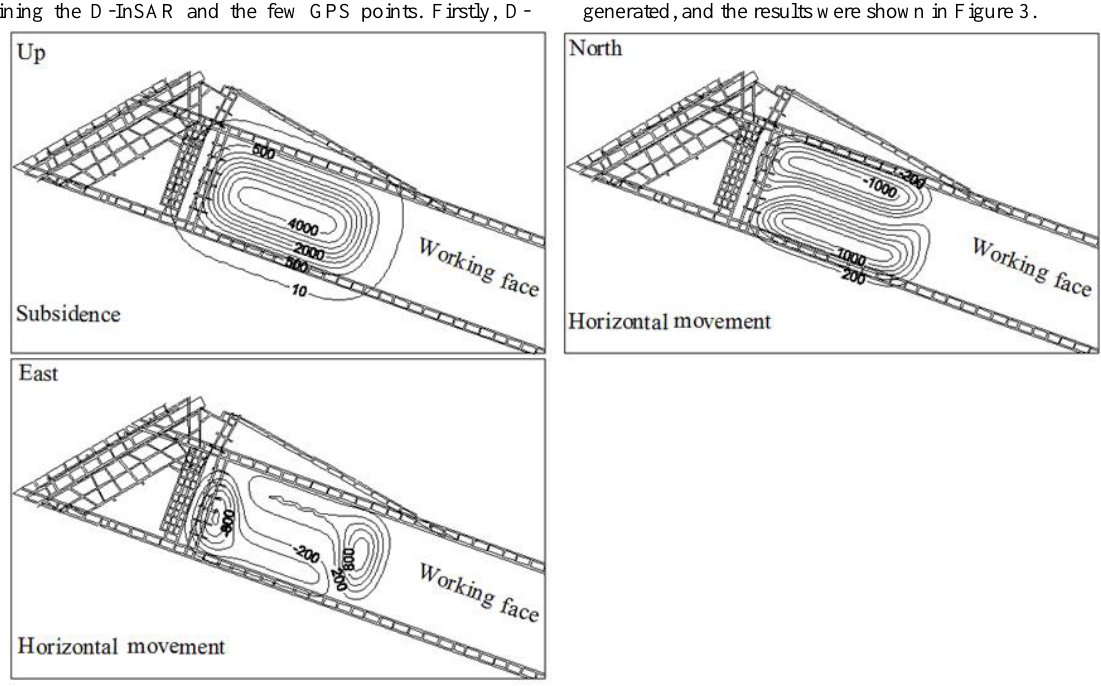
Figure 3. Three-dimensional deformation genrated by